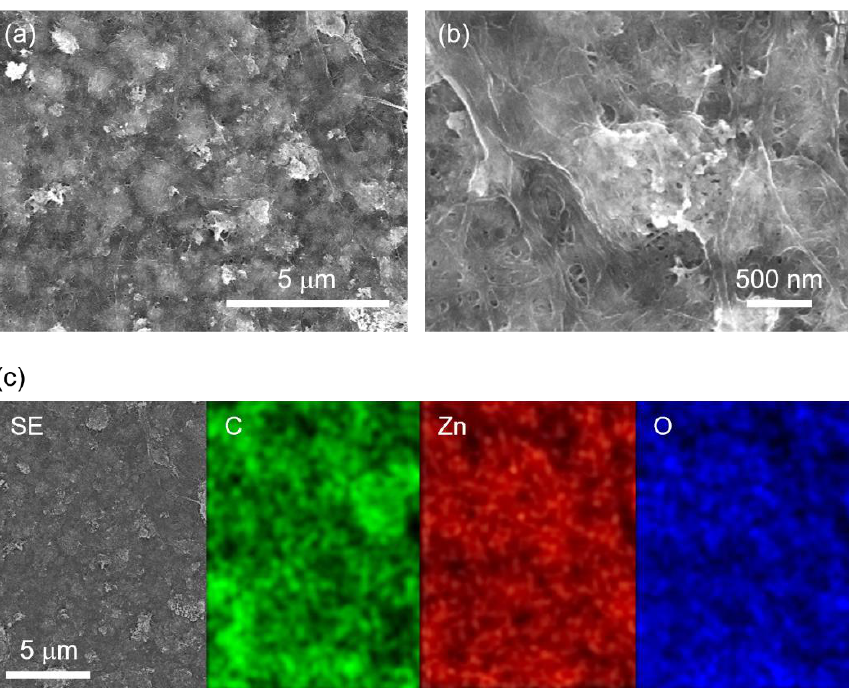
Figure 2. SEM images of ( a ) low and ( b ) high magnification of the nanocomposite film with 45 wt.% ZnO. ( c ) Secondary electron image and EDX elemental mappings of C, Zn, and O of nanocomposite film with 45 wt.% ZnO.